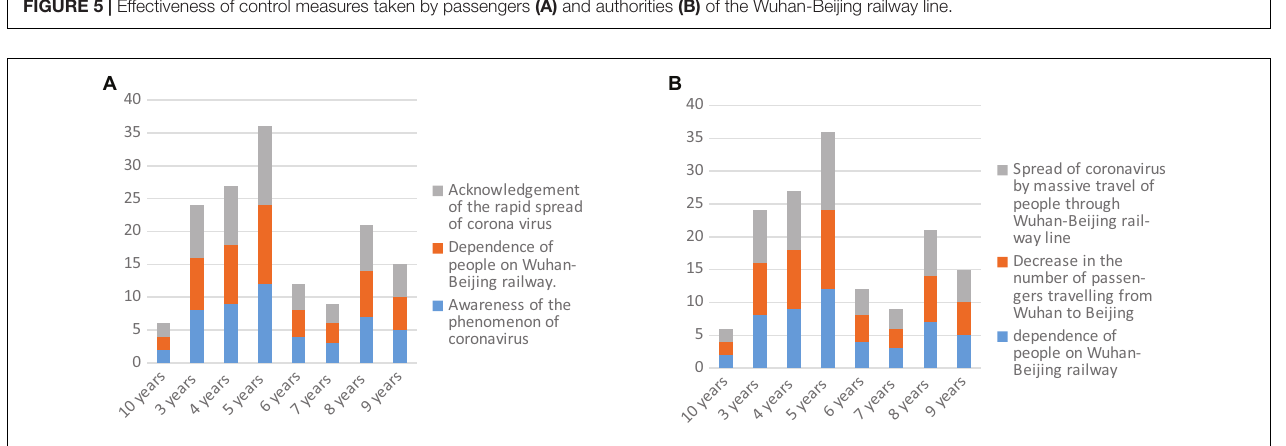
FIGURE 6 | (A) Acknowledgment of the respondents and (B) passenger flow on the Wuhan-Beijing railway line.